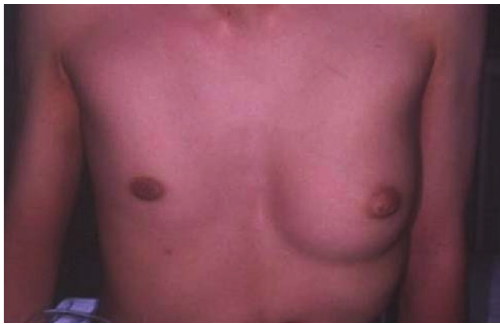
Figure 6: Preoperative view.